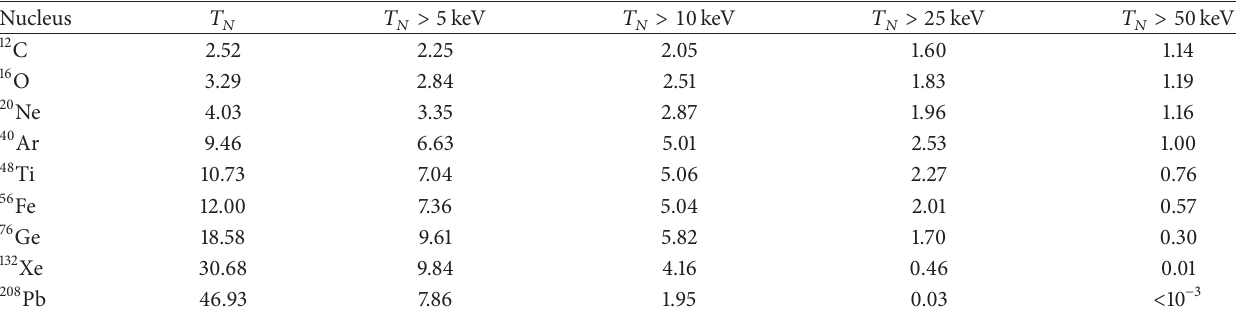
Figure 4: The signal cross sections that represent the expected signal to be recorded on a terrestrial nuclear ] -detector, (a) for supernova neutrinos (𝜉 = SN ) , evaluated with Maxwell-Boltzmann distributions at 𝑑 = 10 kpc, and (b) for SNS neutrinos (𝜉 = lab .) , at 20 m from the source. For the case of SNS neutrinos, the figure takes into account only the delayed beam, evaluated with the generic flux of Φ ] 10 7 ] s −1 cm −2 . Different nuclear detectors have been studied. Table 2: Flux averaged cross sections ⟨𝜎 ] ⟩ 𝜉 in units 10 −40 cm 2 for the adopted supernova ( 𝑑 = 10 kpc) and laboratory (delayed flux only) neutrino spectra. For the case of SNS neutrinos, we adopt the generic flux, that is, Φ ] Nucleus 12 C 16 O 20 Ne 28 Si 40 Ar 48 Ti 56 Fe 76 Ge 132 Xe 208 Pb ⟨𝜎 ⟩ 1.46 ] SN ⟩ ⟨𝜎 ] lab . Table 3: Total number of events per ton of the target materials for a supernova at a distance of 10kpc. We assume various energy thresholds 5, 10, 25, or 50keV. Our present results are in excellent agreement with those of [25, 35].